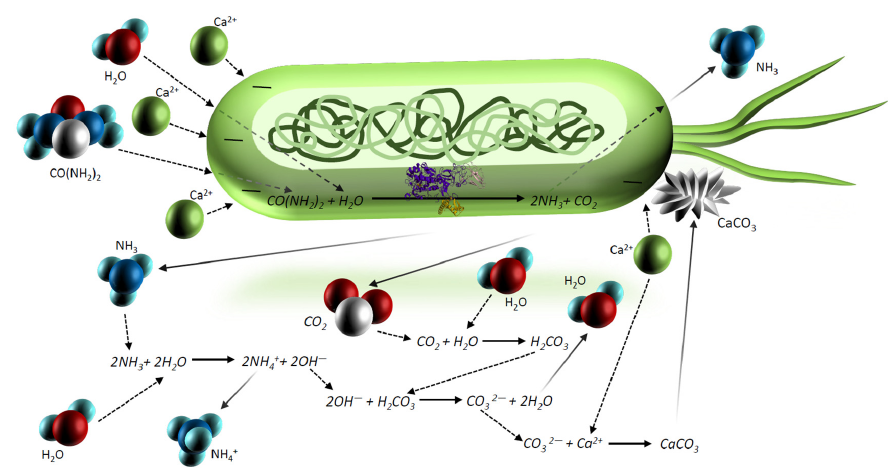
Figure 2. A representation of calcite precipitation due to the MICP method.